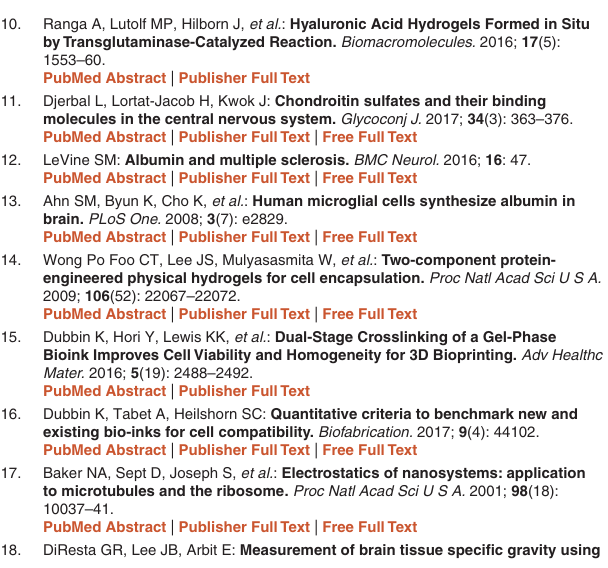
Data is available under a CC0 1.0